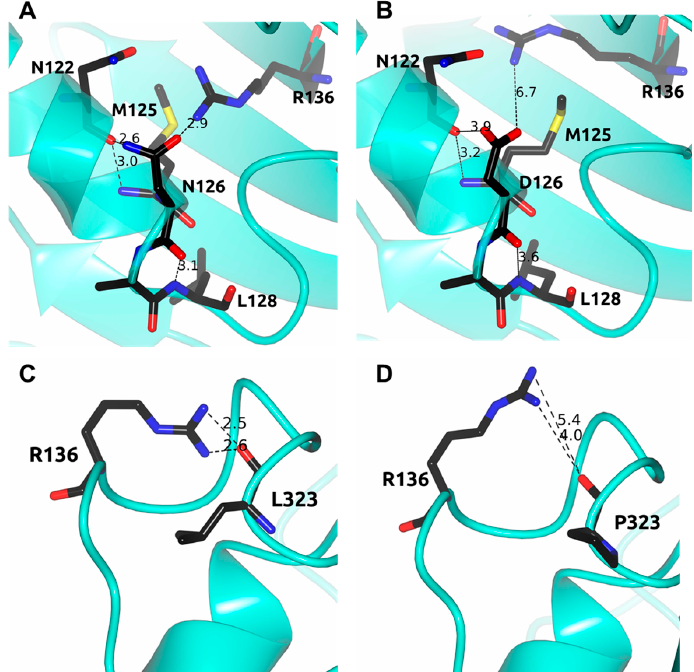
Figure 9. Structural comparison between the human G6PD enzyme (PDB entry 2BH9) and the minimized models of the Class III A+ and Nefza variants. ( A ) WT G6PD enzyme; ( B ) in silico N126D mutation; ( C ) WT G6PD enzyme; and ( D ) in silico L323P mutation. Residues are shown as black cylinders. Distances are in Å.